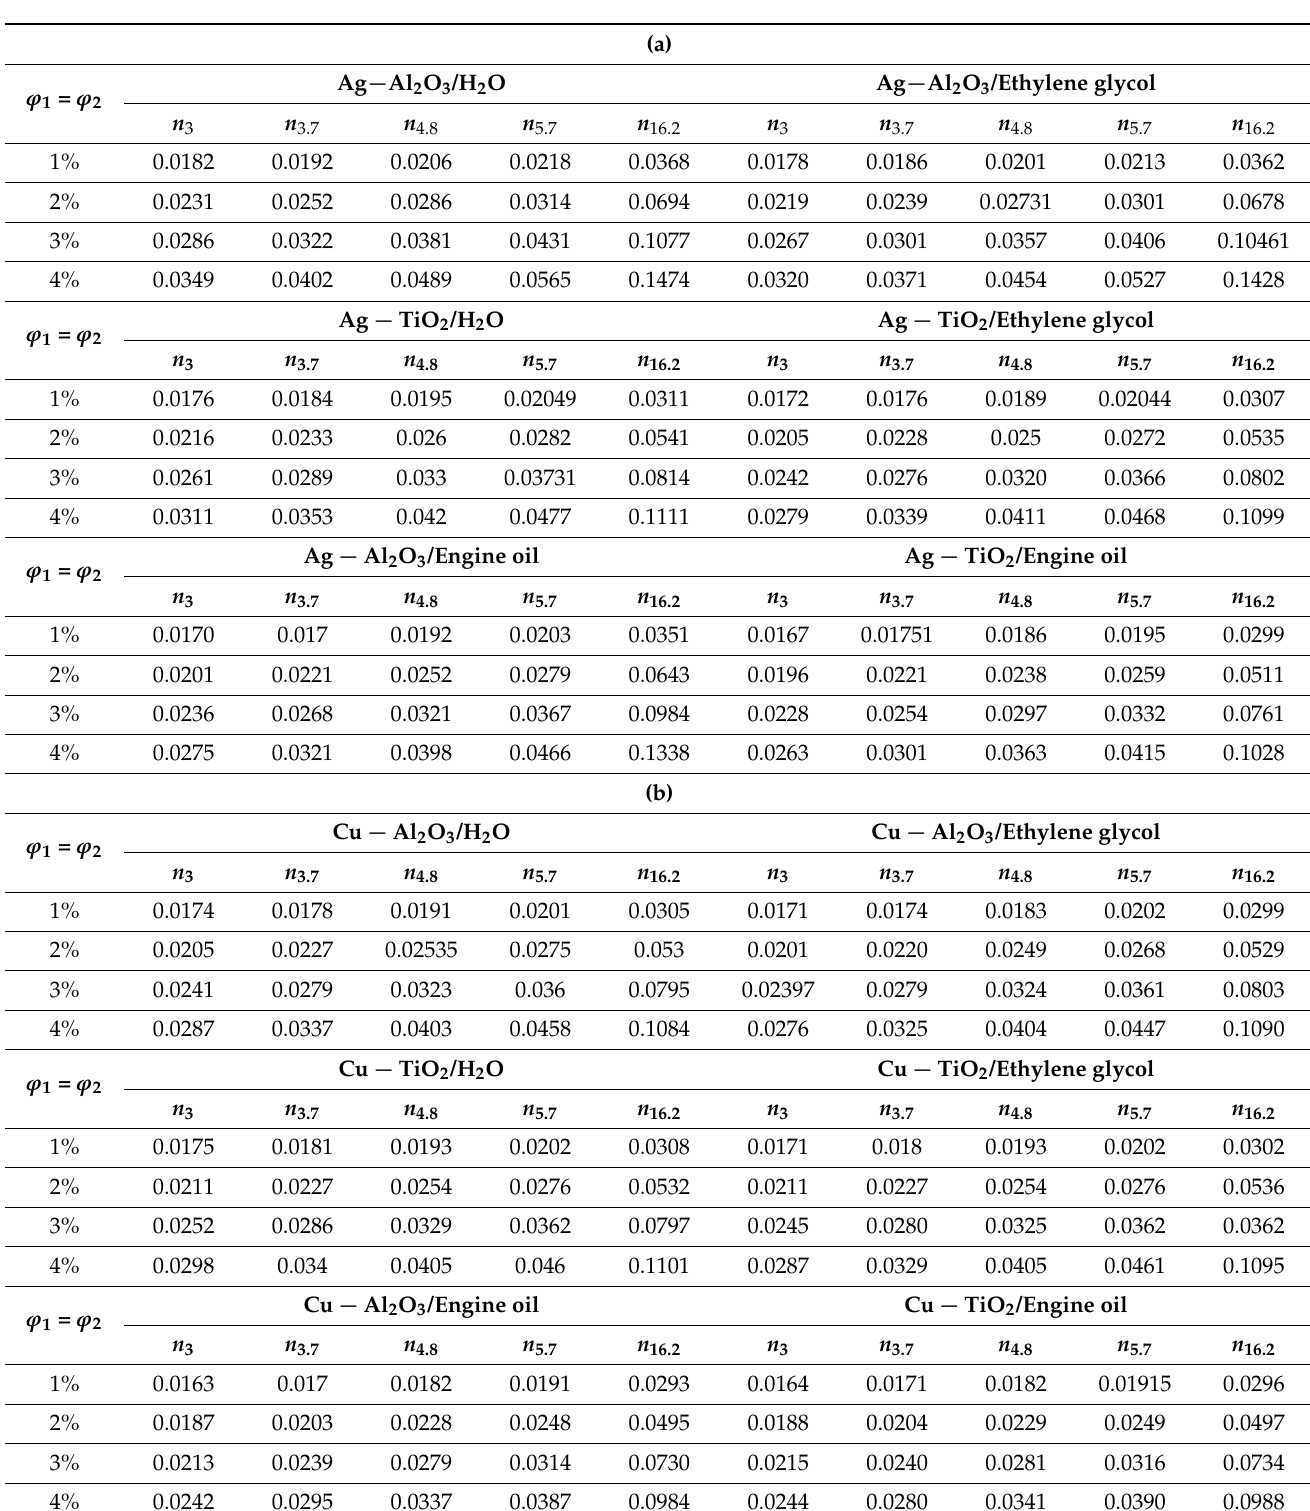
Table 3. ( a ) Numerical size factor effect of heat transfer in different hybridized nanofluids. ( b ) Nu- merical size factor effect of heat transfer in different hybridized nanofluids.